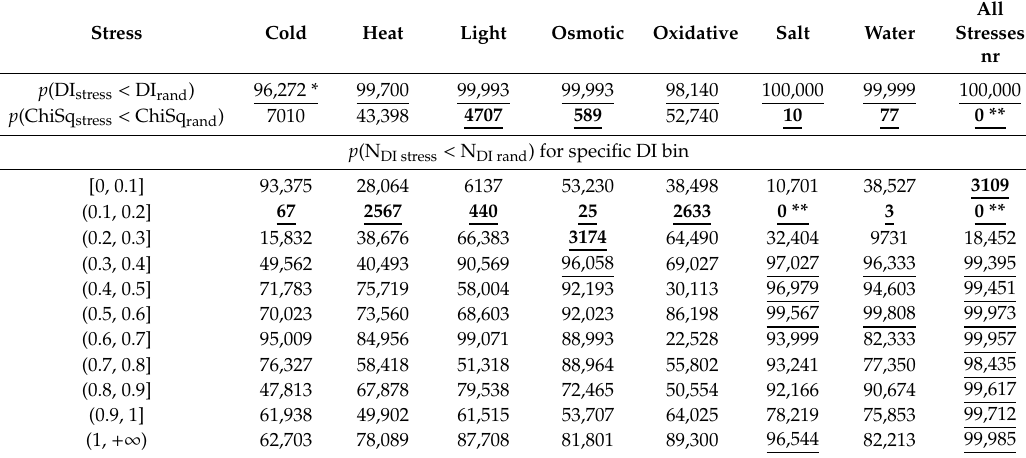
Table 4. Comparison of the divergence index (DI) distribution of genes in the gene networks of A. thaliana stress response with the corresponding distribution of the complete set of A. thaliana genes according to the results of the permutation test. First line: types of stress. Second line: the proportion of random samples for which the average DI rand value for a set of genes, the same size as the stress network, exceeds the DI stress value for the corresponding stress network. Third line: fraction of random samples of genes in which the value of the quadratic deviation ChiSq rand distribution of DI from such distribution for all genes is higher than in the corresponding gene networks (ChiSq stress ). The fifth and subsequent lines: fraction of random samples of genes in which the di ff erence between the proportion of genes of i -th phylostratum dfDI i among stress genes exceeds the corresponding proportion among a random sample formed from the whole gene set. All values in the cells must be multiplied by 10 − 5 . Stress Cold Heat Light Osmotic Oxidative Salt Water